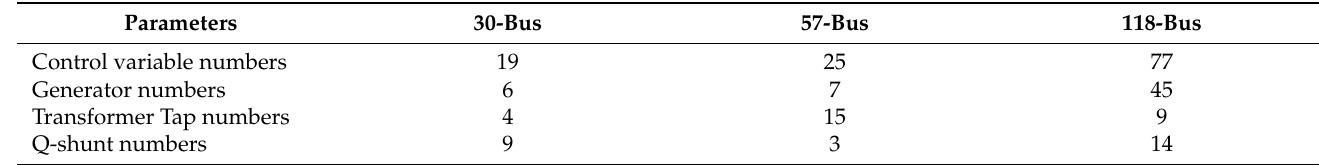
Table 4. The description of proposed test systems.